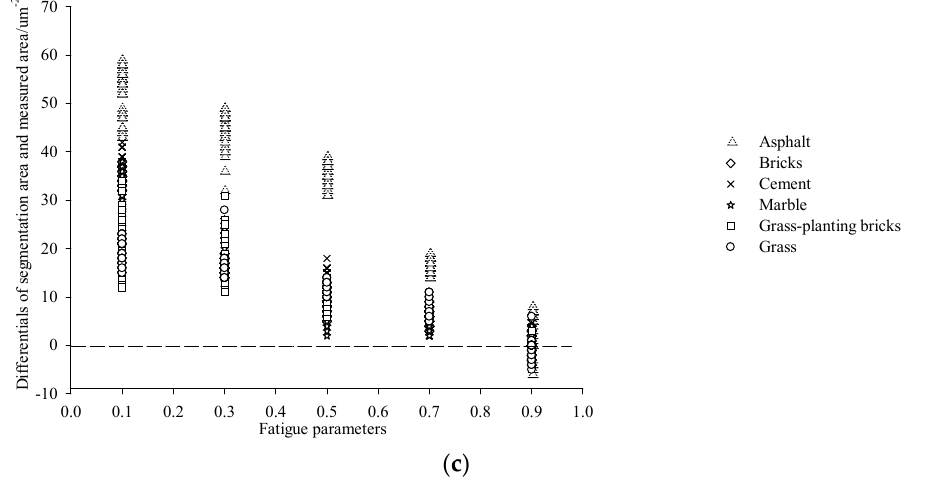
Figure 5. Scatter plot of the d-values between the multiscale segmentation and the measured density. ( a ) Scale parameters; ( b ) shape parameters; ( c ) fatigue parameters.